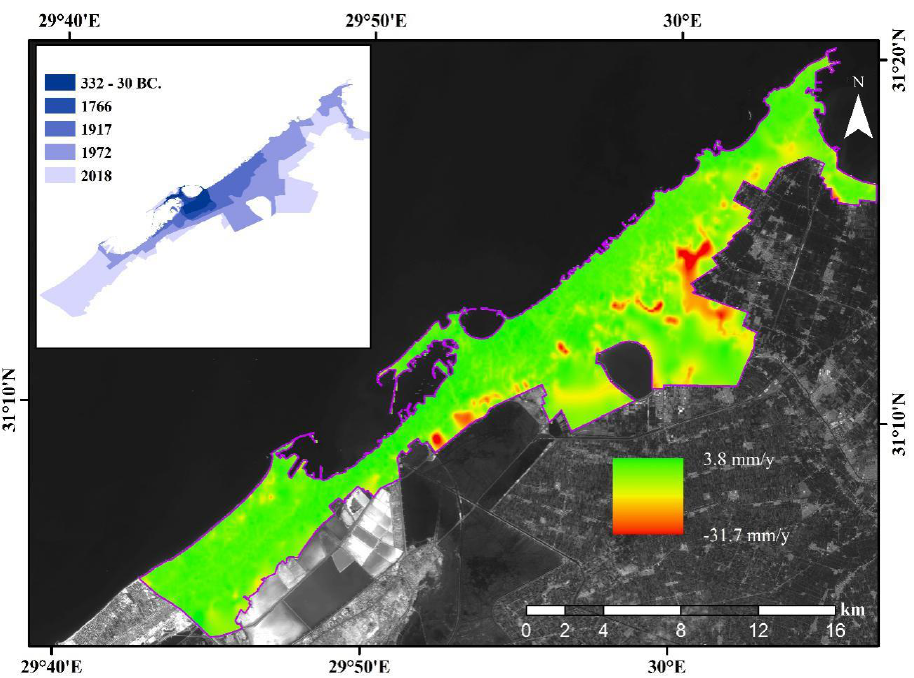
Figure 8. Vertical displacement in Alexandria presented on the Sentinel-2 gray image of 24 October 2018 blue band, with the city area evolution along the history presented in the sub-data frame.